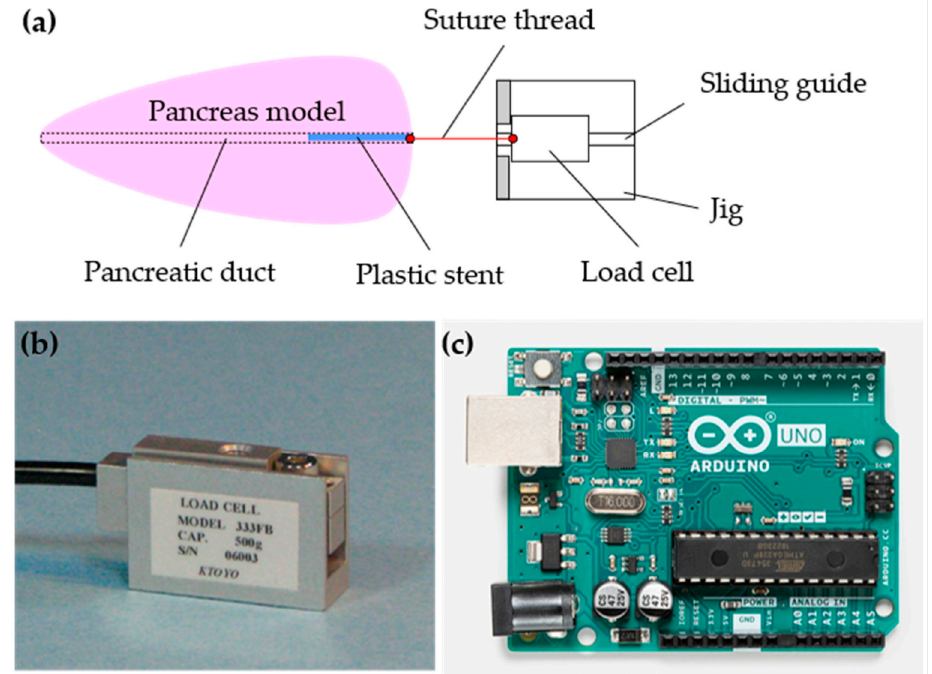
Figure 3. Design of the measuring device for antimigration effects and main components: ( a ) schematic image of the measuring method, ( b ) load cell (KTOYO/333FB, Gyeonggi-do, Korea), and ( c ) microcontroller (Arduino UNO R3, Arduino AG, Somerville, MA,